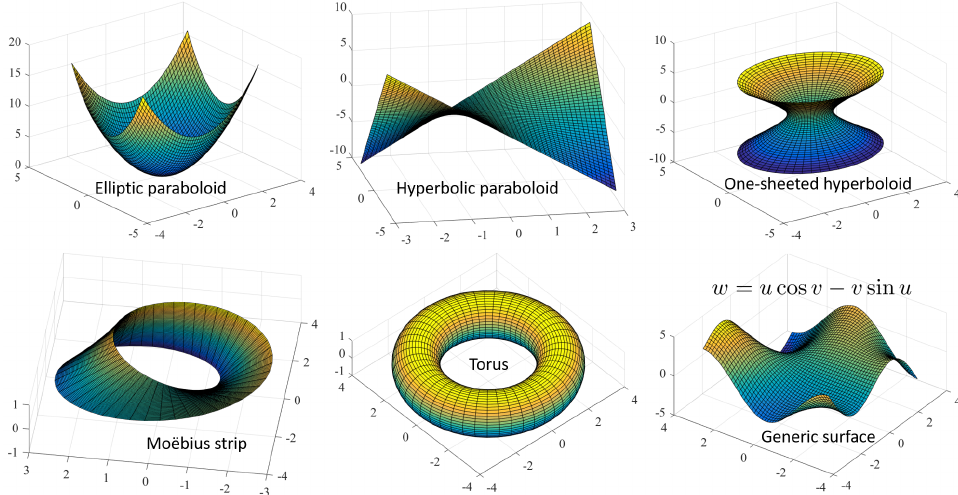
Figure 2. Examples of six tested